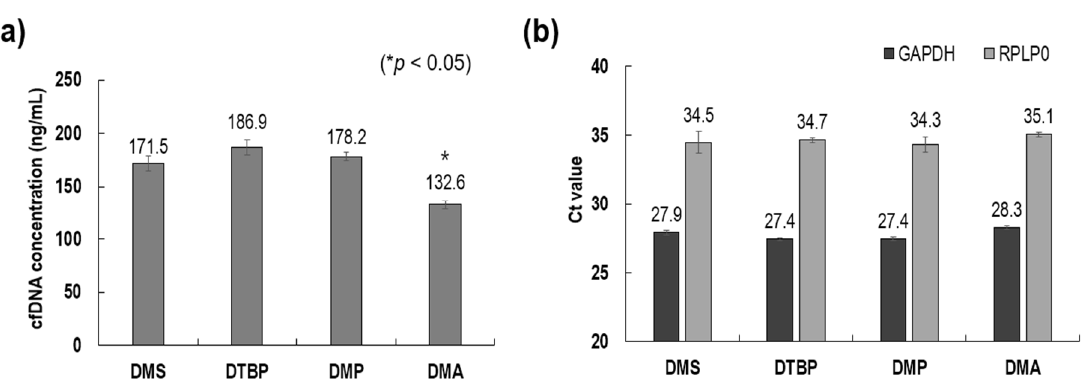
Figure 2. Comparison of cfDNA extraction with different homobifunctional imidoester crosslinkers (DMS, DTBP, DMP, and DMA). ( a ) cfDNA concentrations. ( b ) Threshold cycles for two house-keeping genes ( GAPDH and RPLP 0).